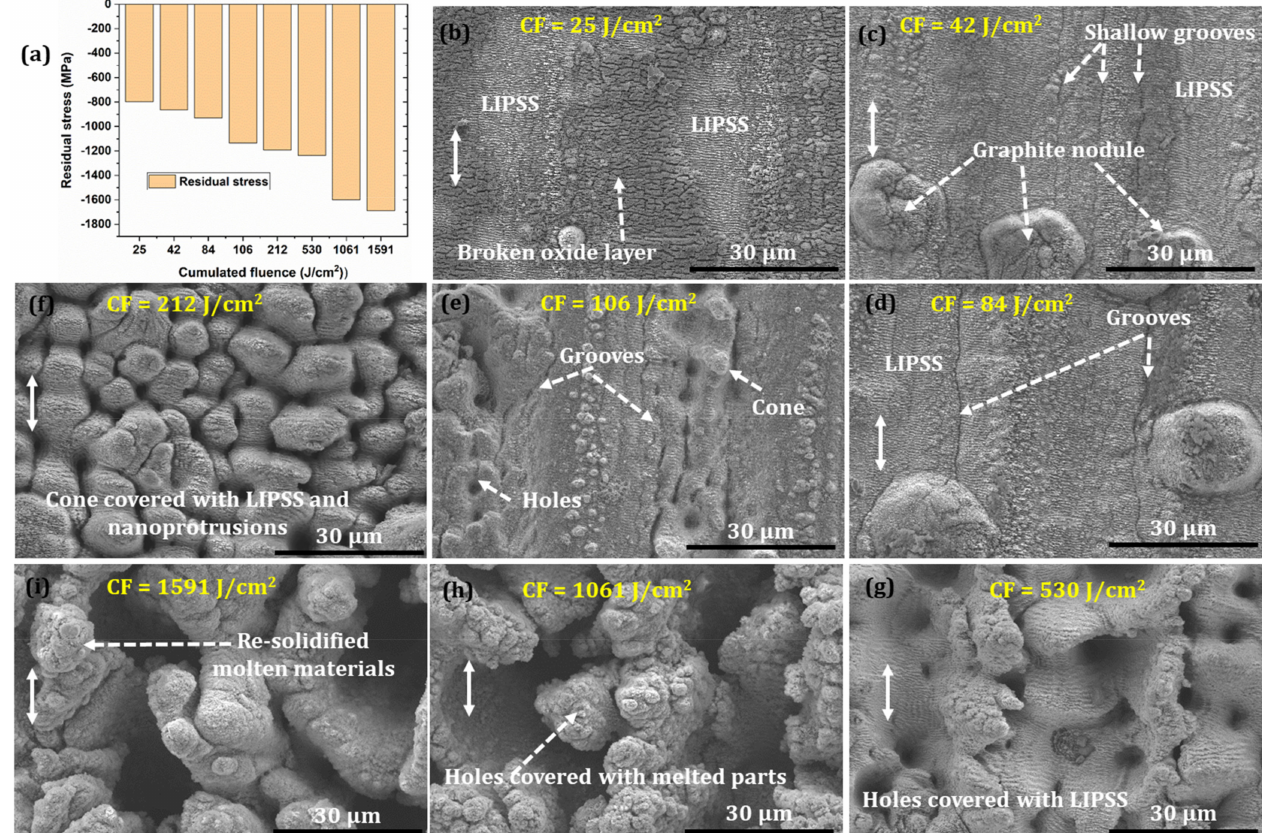
Figure 1. ( a ) Deviation of residual stresses at various CH and ( b – i ) corresponding microstructures. The white double head arrows denote the direction of